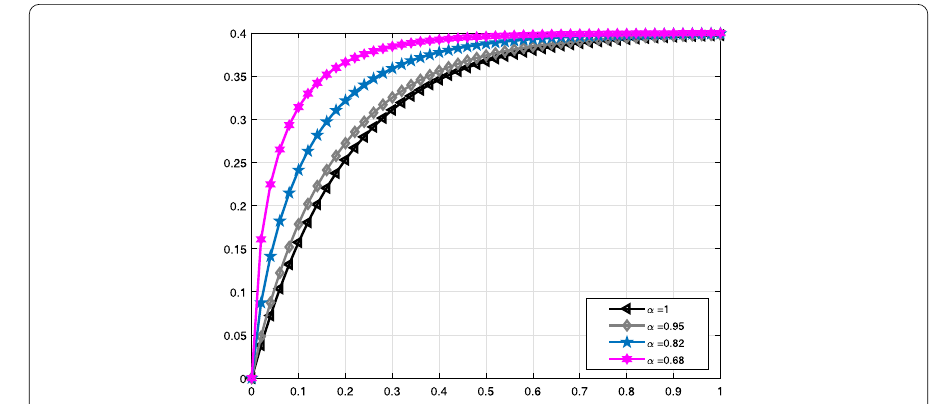
Figure 3 Comparative analysis with conformable derivative for V i ( t )